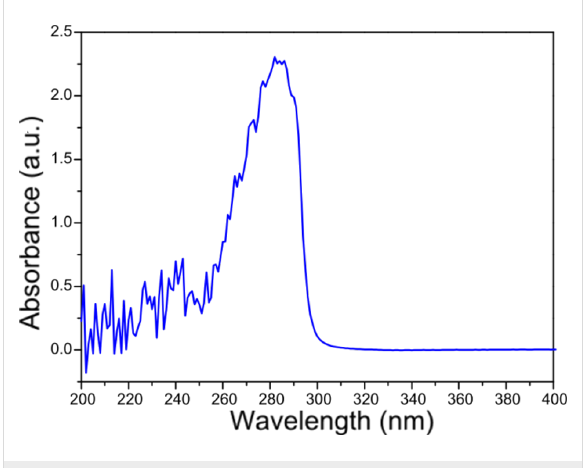
Figure 1: UV–vis spectrum of a tin dioxide colloid stabilised with PEI.